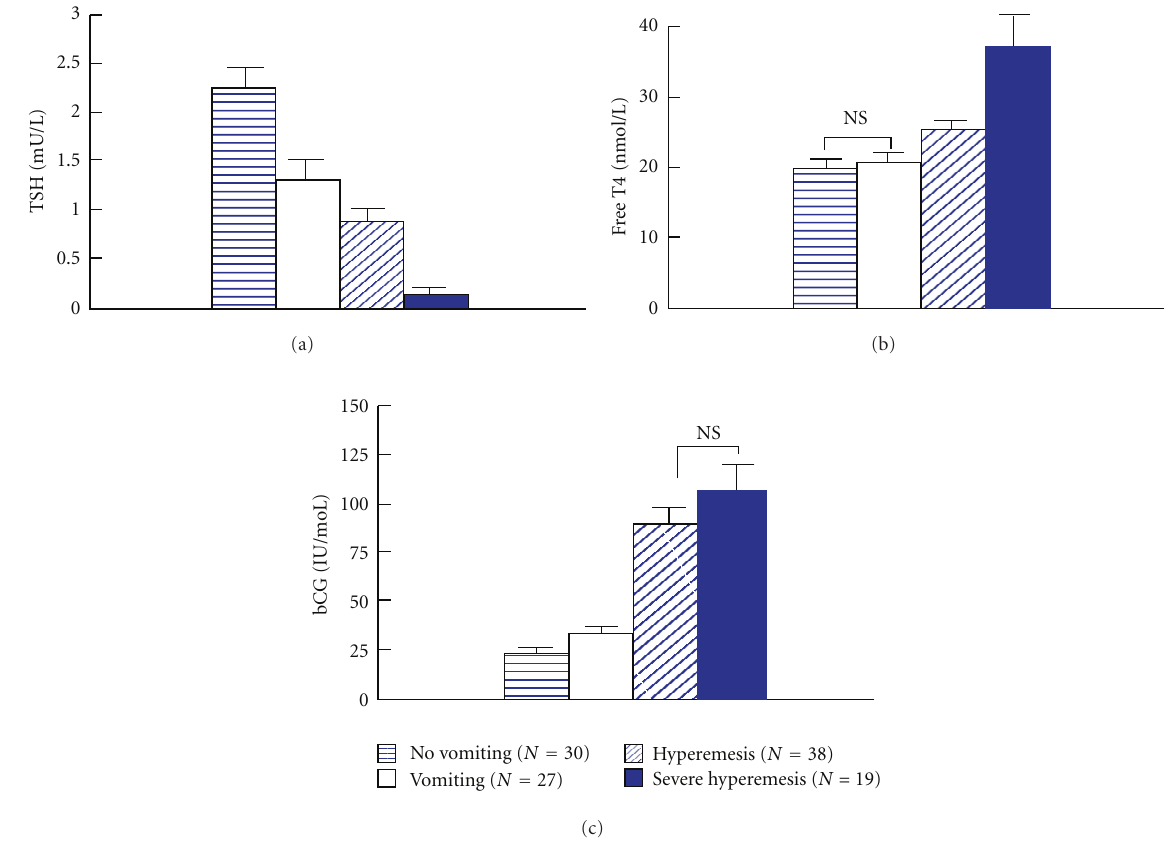
Figure 4: Relation between the severity of vomiting and serum concentrations of TSH, free T4, and hCG (mean + SE). Hormone concentrations di ff ered significantly between each group of patients except as indicated by NS Goodwin et al.